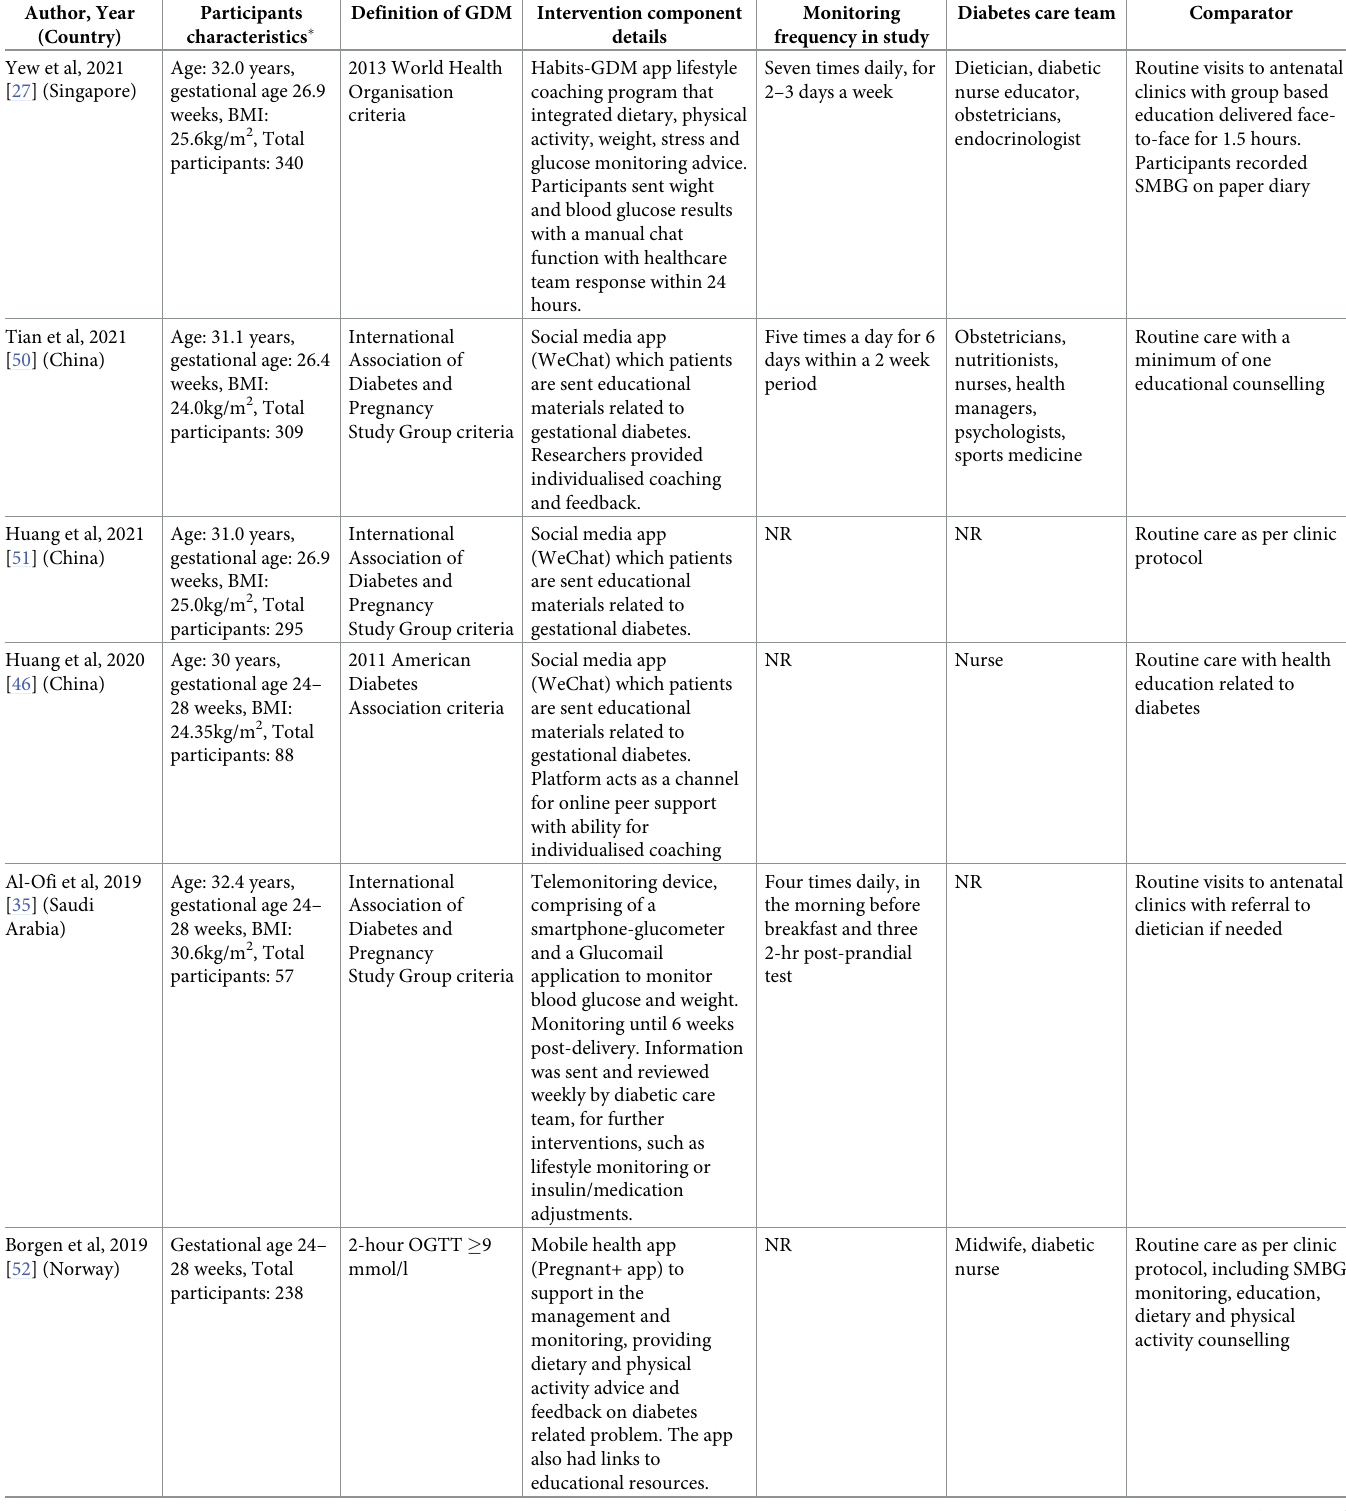
Table 2. Characteristics of included